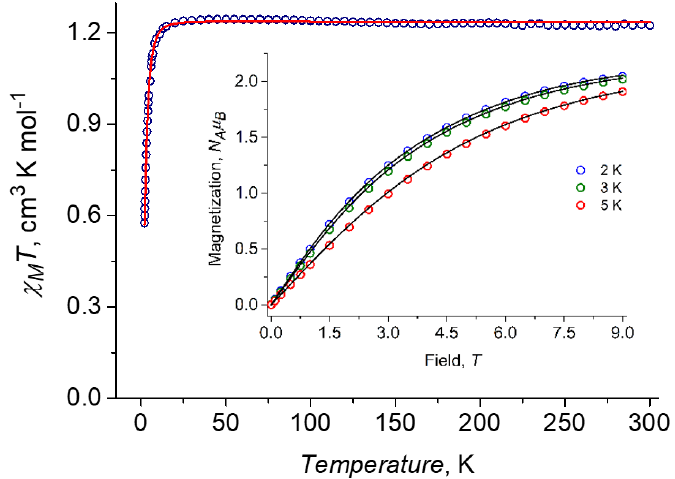
Figure 11. Temperature dependence χ M T for 4 measured under a 5000 Oe magnetic field (open circles). Inset: Magnetization vs. field for 4 measured at T = 2, 3, and 5 K. The theoretical curves (solid lines) were calculated with the optimal set of parameters (Table 5).